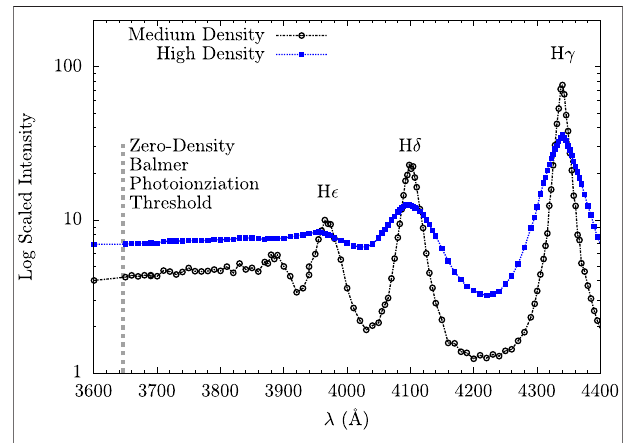
FIGURE 1 | Balmer series emission data of Wiese et al. (1972), on an arbitrary relative scale. According to Wiese et al. (assuming full LTE), the high density case has n e ≈ 9, ×, 10 16 cm − 3 , T ≈ 13, 000 K, while the medium density case has n e ≈ 2 × 10 16 cm − 3 , T ≈ 10,000 K. In addition to having larger widths, the lines in the high density case are seen to decrease and merge into the continuum more rapidly than in the lower density